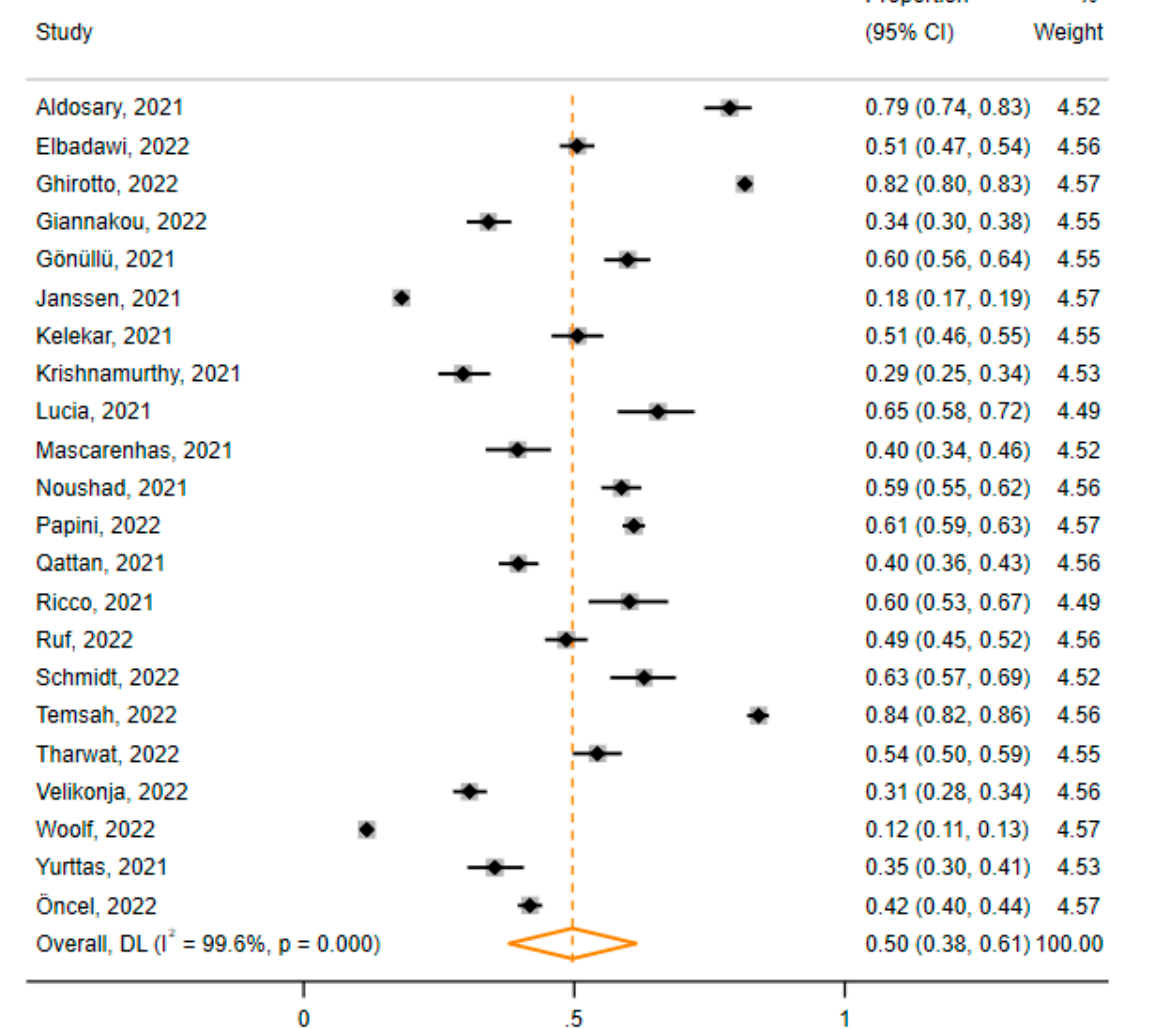
Figure 3. Results of the meta-analysis. The pooled proportion (orange rhombus) of HCWs’ acceptance of mandatory COVID-19 vaccines for the general population was 50% (95% CI: 38%, 61%) [28–49].